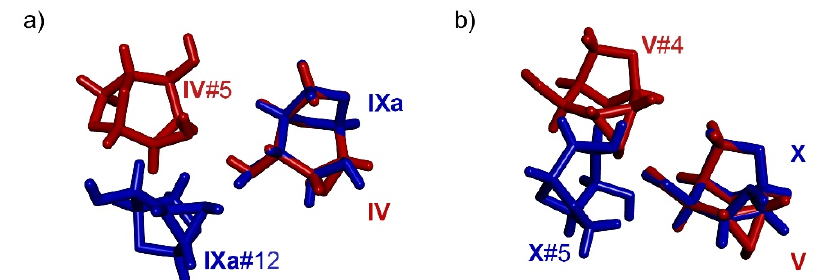
Figure 15. The intermolecular interaction of the OH group in the C4 ‐ OH ax epimines ( a ) and the C4 ‐ OH eq epimines ( b ).